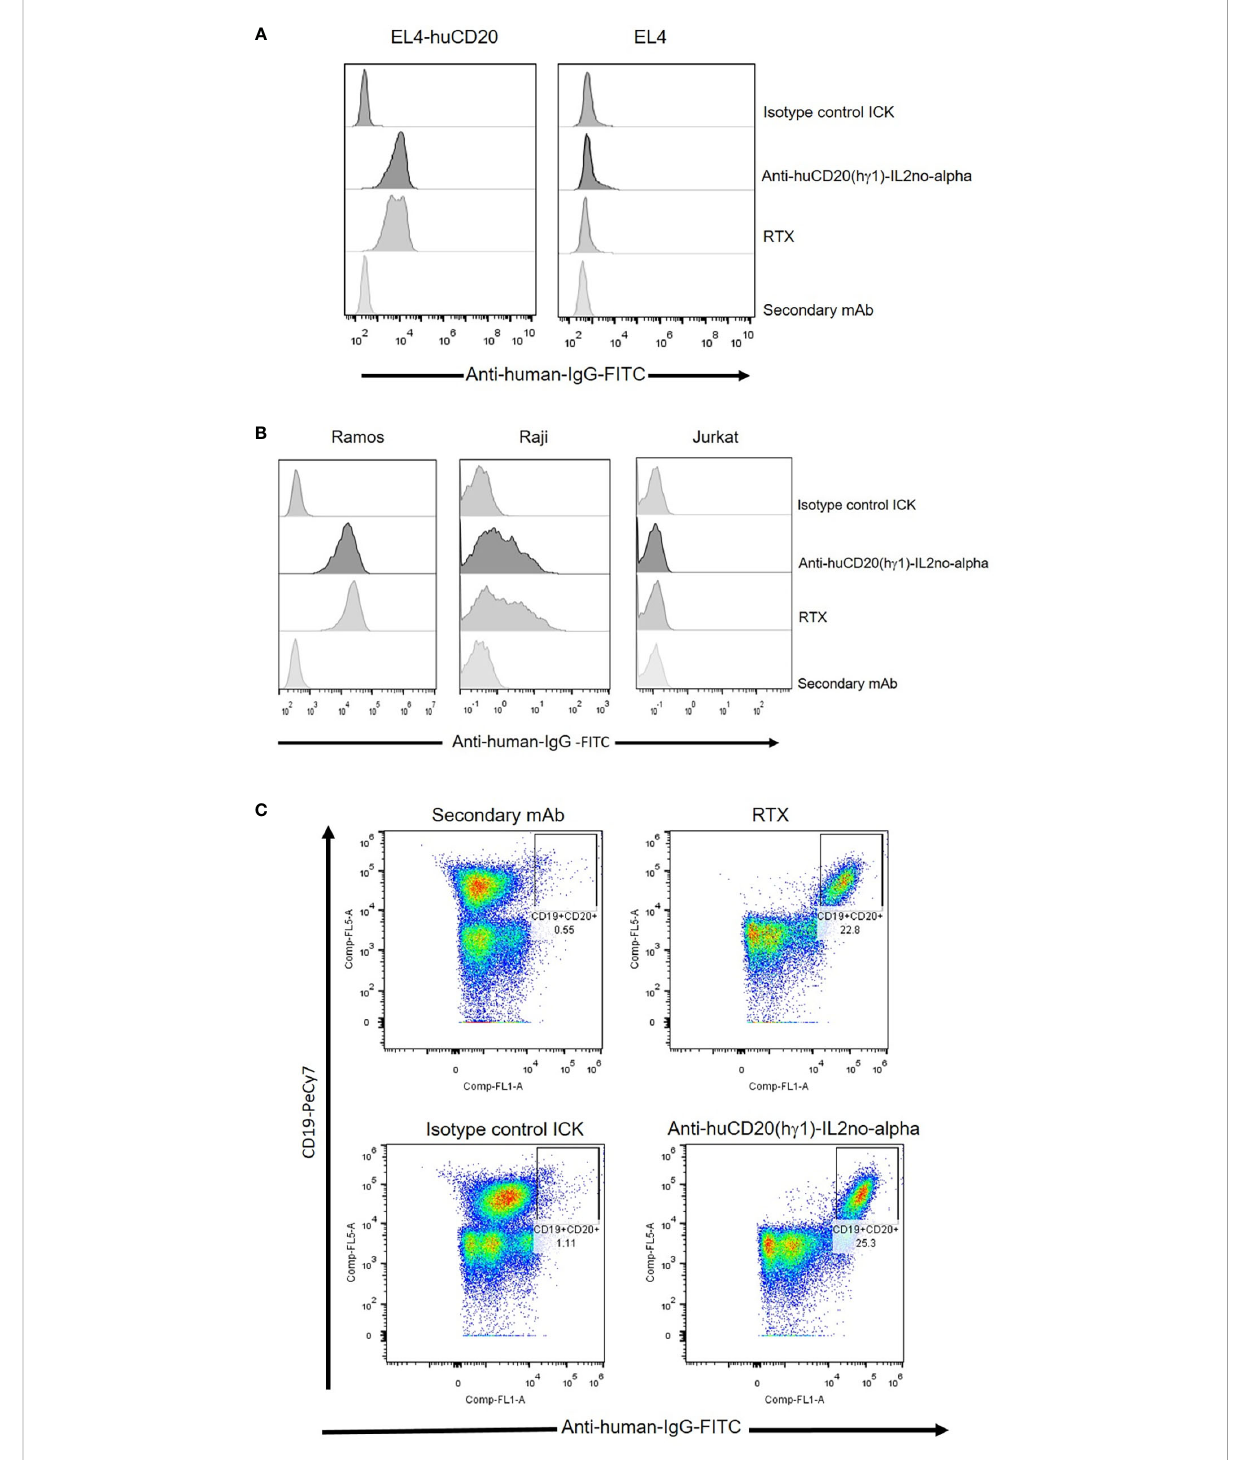
FIGURE 2 Speci fi c binding of anti-huCD20(h g 1)-IL2no-alpha ICK and RTX antibodies as measured by fl ow cytometry. (A) EL4-huCD20 and EL4 cells. (B) Human Burkitt ’ s lymphoma Ramos and Raji cells were stained with equimolar amounts (66 nM) of anti-huCD20(h g 1)-IL2no-alpha or RTX. Jurkat leukemia cells were used as control of non-CD20-expressing cells. (C) PBMC from refractory low- grade B-cell lymphoma. Anti-human IgG-FITC were used as secondary mAb to detect cell-bound